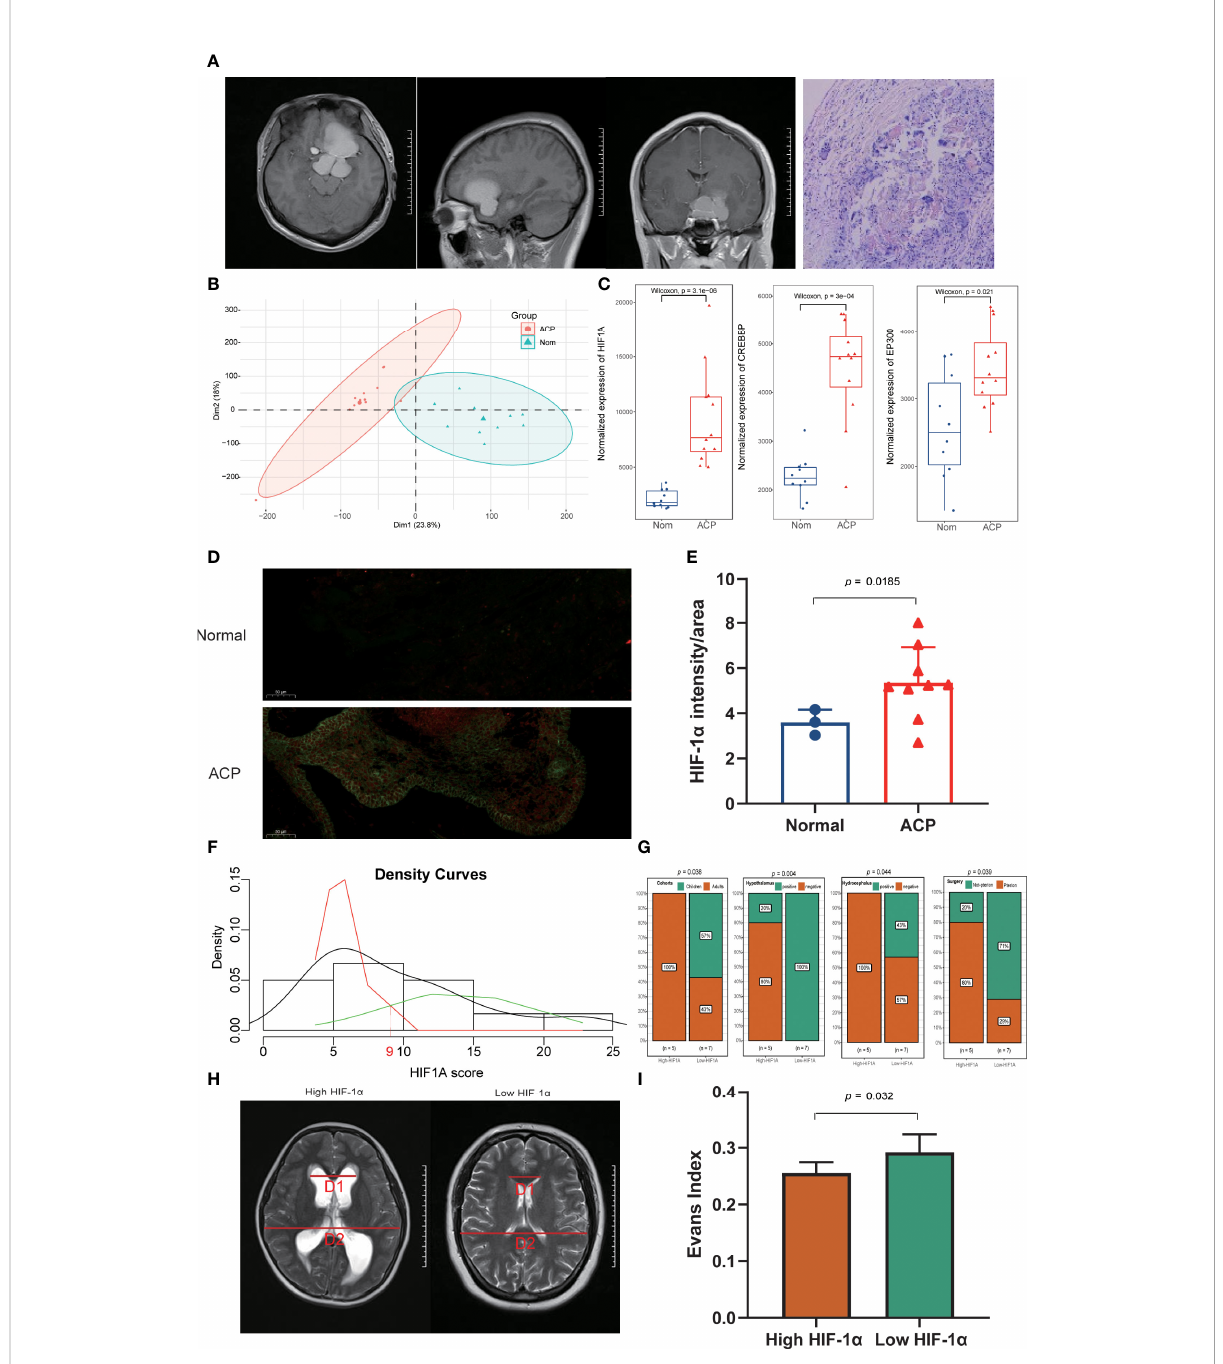
FIGURE 4 Exploration and validation of clinical characteristics of HIF-1 a in ACP patients. (A) . ACP patients enrolled in our study displayed classical neuroimaging and pathological abnormality. (B) . The principal component analysis (PCA) exhibited the inner homogeneity of ACPs different from the health controls at the gene expressional levels. (C) . Higher expression levels of both HIF-1 a and CREBBP were detected in ACP patients, while there was no statistical difference for EP300 compared with the expression in control groups. (D, E) . The immuno fl uorescence staining of ACP histological sections consistently validated their higher expression at protein levels in ACP patients. (F) . ACP patients were successfully divided into high- and low- HIF-1 a score subgroups based on the Candidate score 9 as the expressional threshold via the double normal distribution model. (G) . The low-HIF-1 a score cohorts included all children patients, exhibited more severe clinical phenotypes including hypothalamus involvement and hydrocephalus, and received non-pterional approaches. (H, I) . The low-HIF-1 a score patients exhibited more signi fi cant cerebroventricular expansion than that of high-HIF-1 a patients with a higher Evans